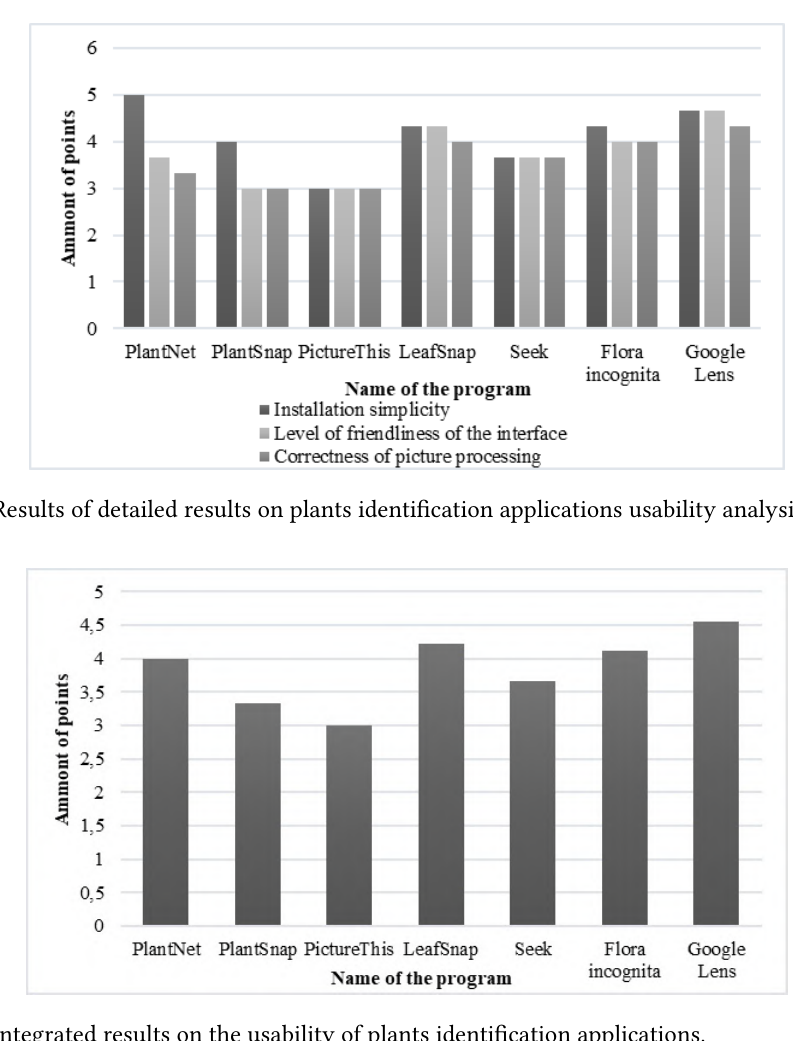
Figure 8: Integrated results on the usability of plants identification